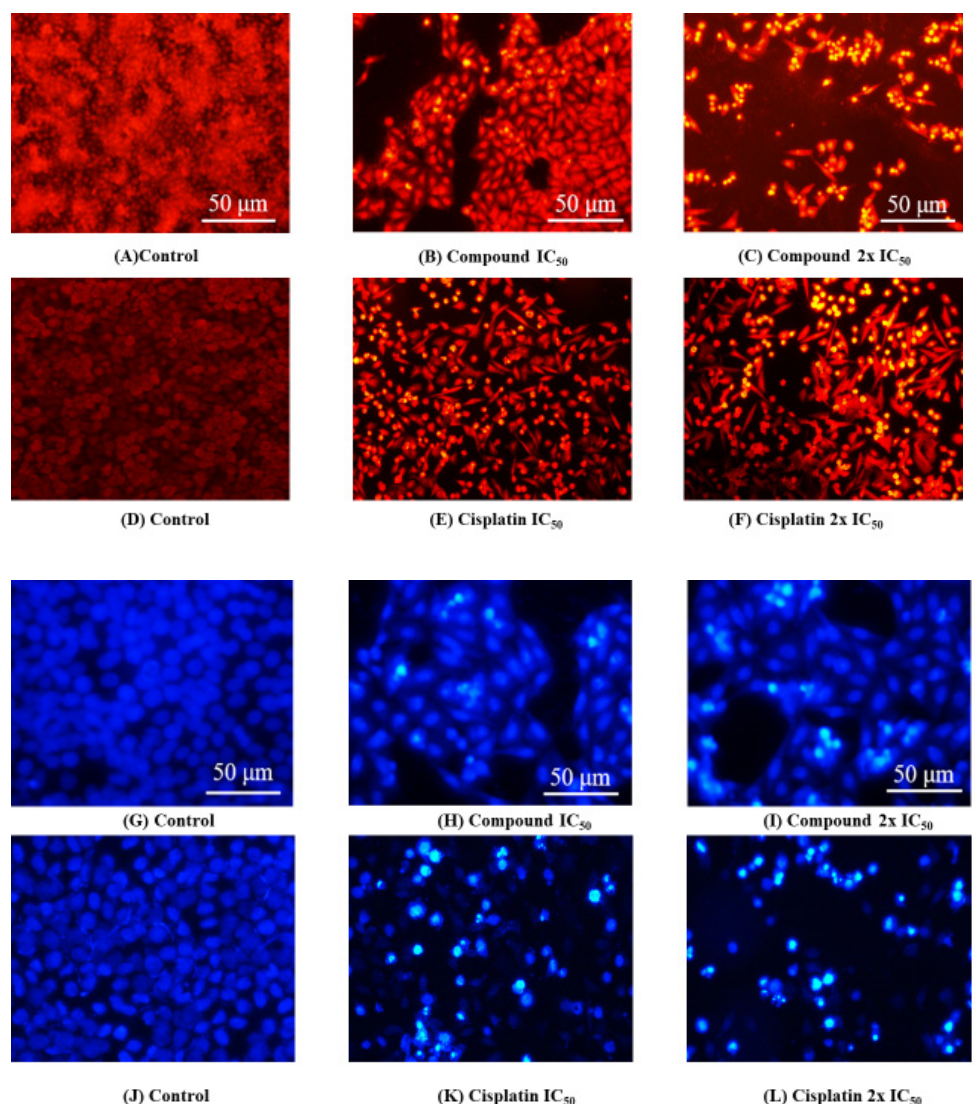
Figure 4. Fluorescence images showing the morphological features of the apoptosis observed in HeLa cells at IC 50 and 2 × IC 50 values of compound 4d with respect to the control after PI staining ( A – C ); the standard drug (cisplatin) is also similarly displayed at IC 50 and 2 × IC 50 values with respect to the control after the PI ( D – F ) staining agent. The morphological changes appear in the apoptotic nuclei perceived in the HeLa cells during apoptosis at IC 50 and 2 × IC 50 values of compound 4d with respect to the control after the DAPI ( G – I ) staining agent. The standard drug (cisplatin) is displayed in the same way at IC 50 and 2 × IC 50 values of with respect to the control after the DAPI ( J – L ) staining agent.